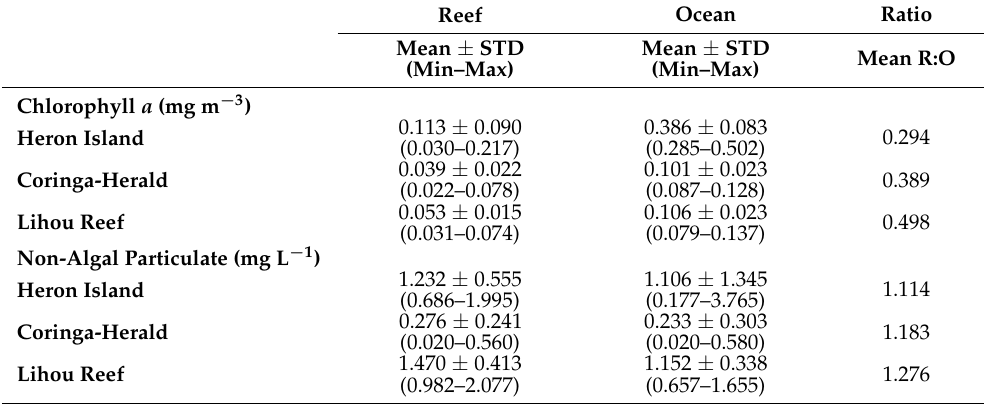
Table 1. The statistics for the chlorophyll a and non-algal particulate matter concentrations for the reef and adjacent ocean waters of Heron Island, the Coringa-Herald cays, and the Lihou Reef.